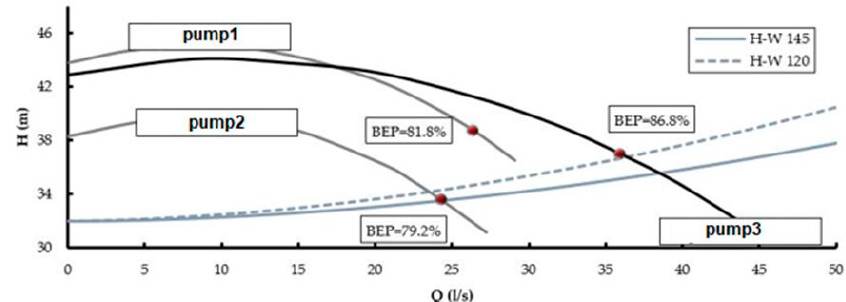
Figure 3. Di ff erent pumps and system curves for di ff erent head losses. Figure 3. Different pumps and system curves for different head losses.